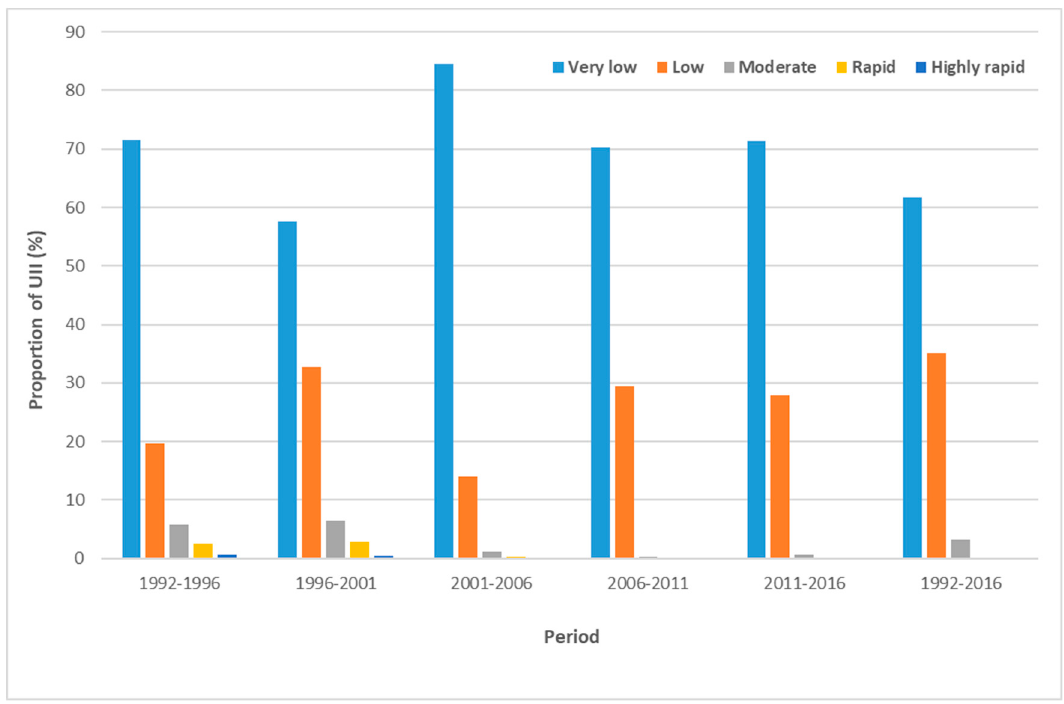
Figure 7. Proportion (%) of Urban Expansion Intensity Grids in Miami MSA.